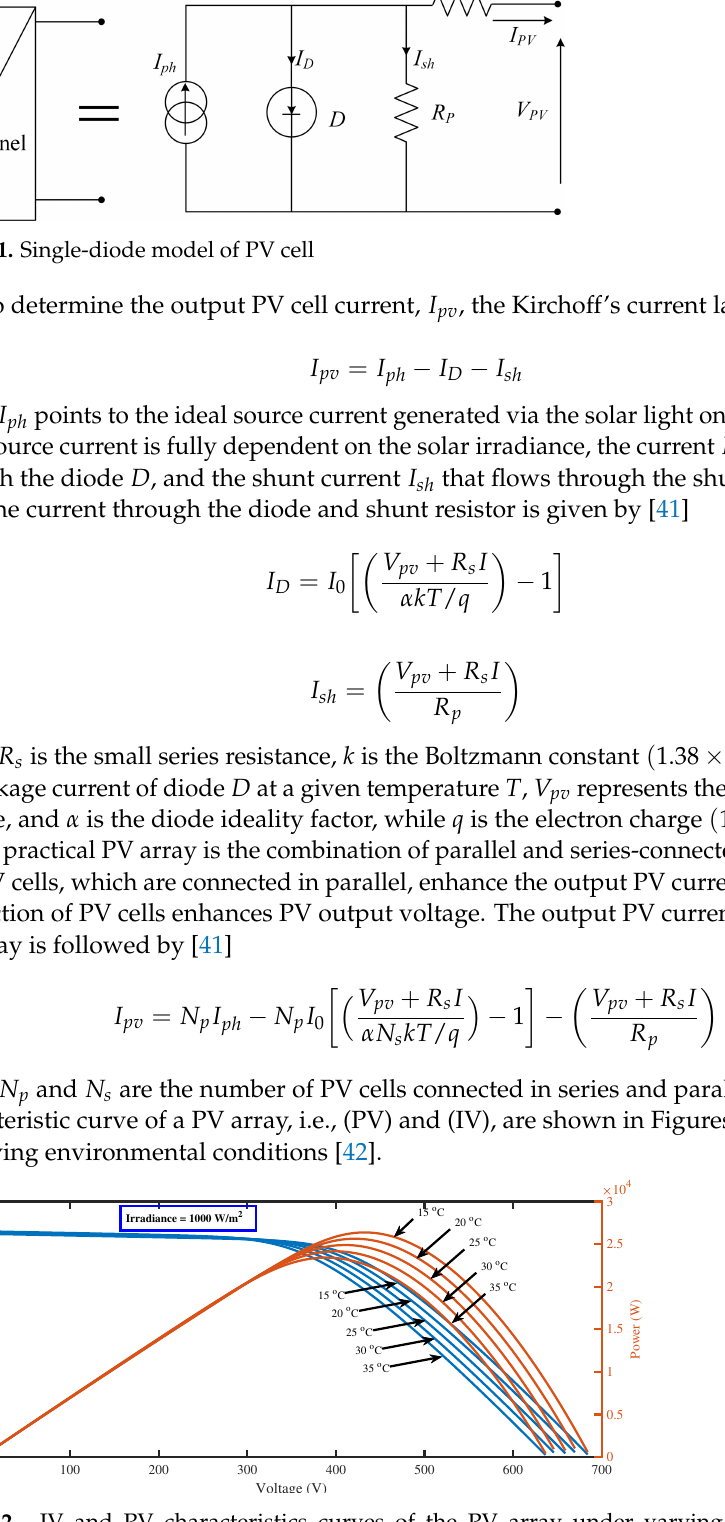
Figure 2. IV and PV characteristics curves of the PV array under varying temperature and constant